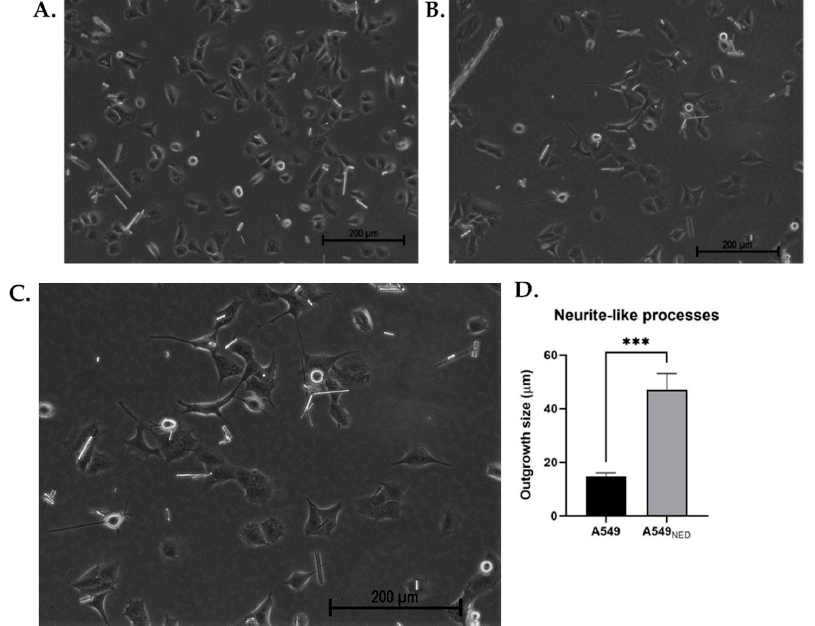
Figure 1. Morphological changes in A549 cells treated with FSK and IBMX. Undifferentiated A549 cells show normal epithelial morphology ( A ) whereas A549 NED cells present neurite-like outgrowths 24 h after treatment with cAMP-elevating agents ( B ). A zoomed-in image of the cells with the largest processes observed in ( B ) is also included ( C ). The bar graph shows the average outgrowth size in treated and untreated cells ( D ); results are presented as the mean ± SEM (n = 3, *** p < 0.001). To further confirm that cells were successfully differentiated, we measured chro ‐ mogranin A (CgA) and synaptophysin (Syn), which are common neuroendocrine mark ‐ ers. Semi ‐ quantitative analysis was performed using RT ‐ PCR and densitometry, deter ‐ mining the relative expression of the genes of interest. As depicted in Figure 2A, reaction products corresponded to the expected sizes for each gene (Syn, 123 bp; CgA, 102 bp; GAPDH, 120 bp). Data were normalized using GAPDH and the control group, obtaining the fold change in relative expression. Both Syn and CgA had a significantly higher ex ‐ pression in A549 NED cells ( p = 0.0356 and p = 0.0467, respectively); on average, A549 NED cells had a 1.491 ‐ fold increase in Syn expression, whereas CgA expression increased 2.051 ‐ fold (Figure 2). These results confirm that treatment with FSK and IBMX induced a neuroen ‐ docrine phenotype in A549 cells.